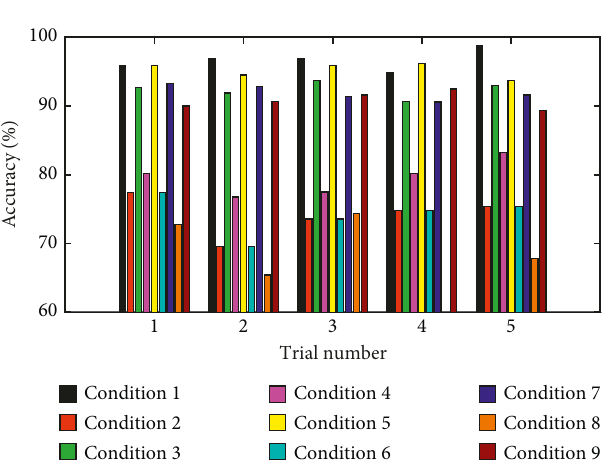
Figure 12: Diagnosis accuracy of the 5 Table 5: The framework of CNN for ablation experiment.